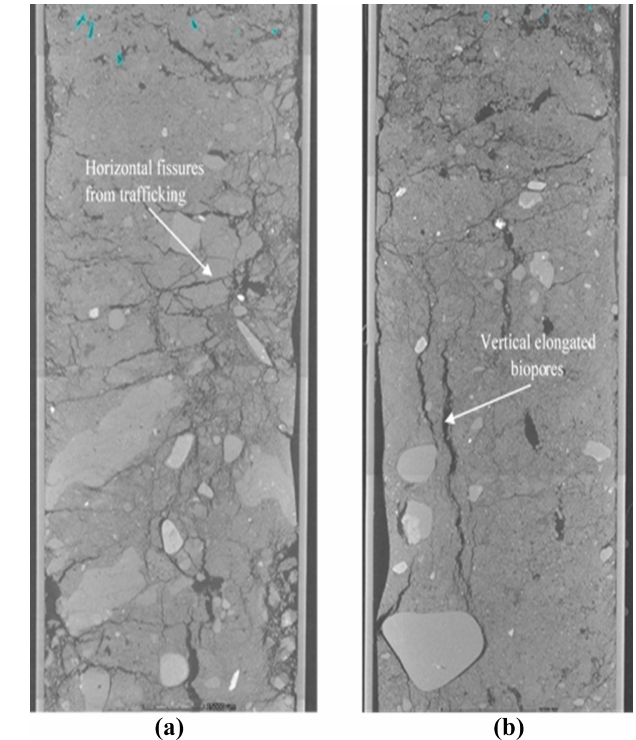
Figure 4. Vertical view of X-ray CT images through the centre of a soil core using VGStudio MAX® software for (a) shallow- tillage conventional-pressure and (b) zero-tillage low-tyre-pressure systems. The scale bar represents